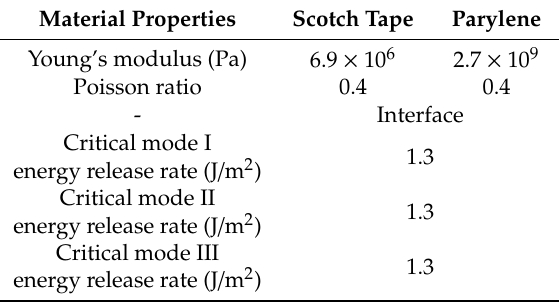
Figure 8. Tensile test result of scotch tape. Table 3. Material properties of materials and